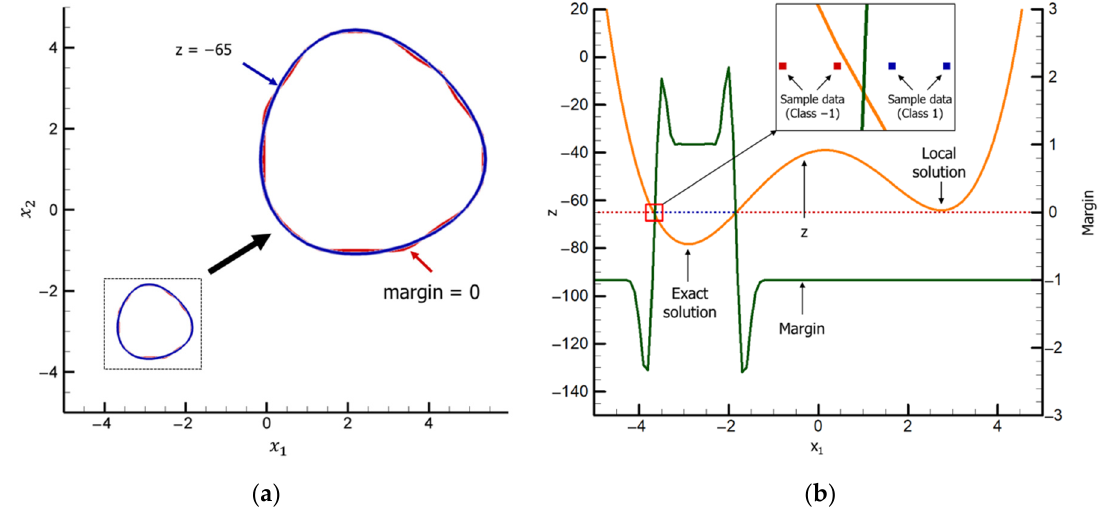
Figure 6. Results analysis ( a ) Class classification criterion and hyperplane ( b ) Comparison of Z and margin ( (cid:1876) (cid:2870) : − 2.9)